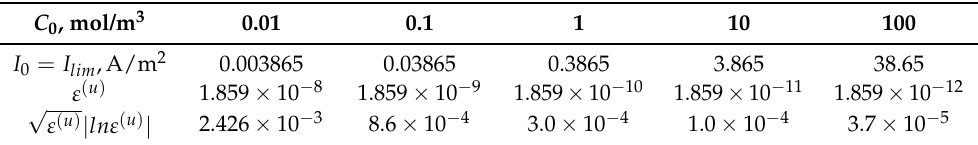
Table A1. Specific values of trivial similarity criteria from C 0 . The last line shows the order of the dimensionless thickness of the quasi-equilibrium region of the space charge at a dimensionless width of the desalination channel equal to